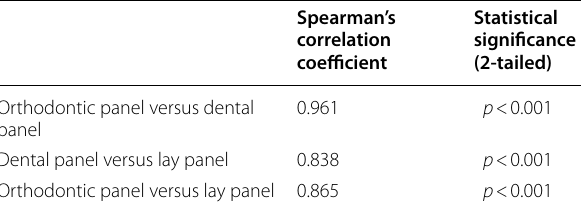
Table 1 Spearman’s bivariate correlation coefficients comparing scores of three panels of